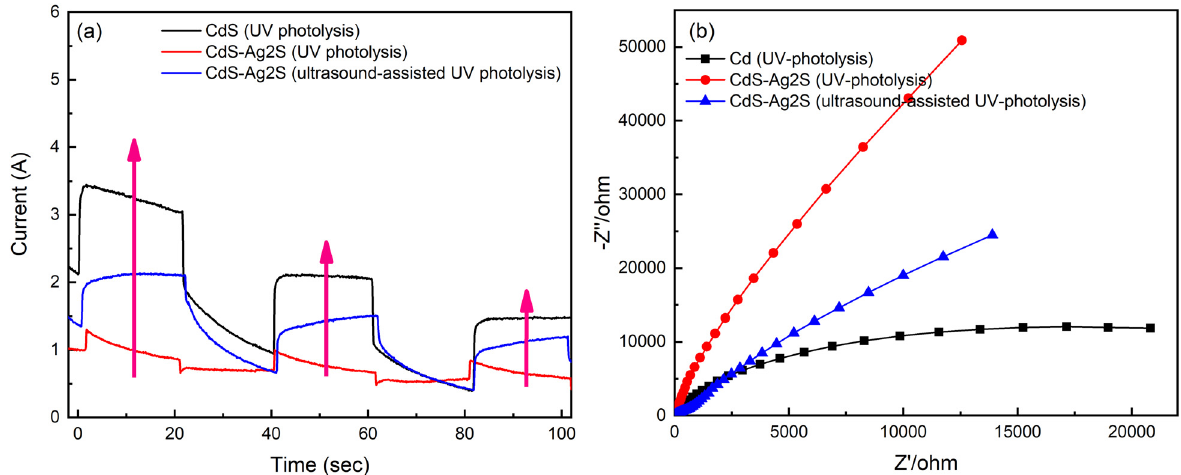
Figure 8: ( a ) Transient photocurrent ( I – t curves ) ; ( b ) electrochemical Impedance Spectroscopy ( EIS ) of di ff erent